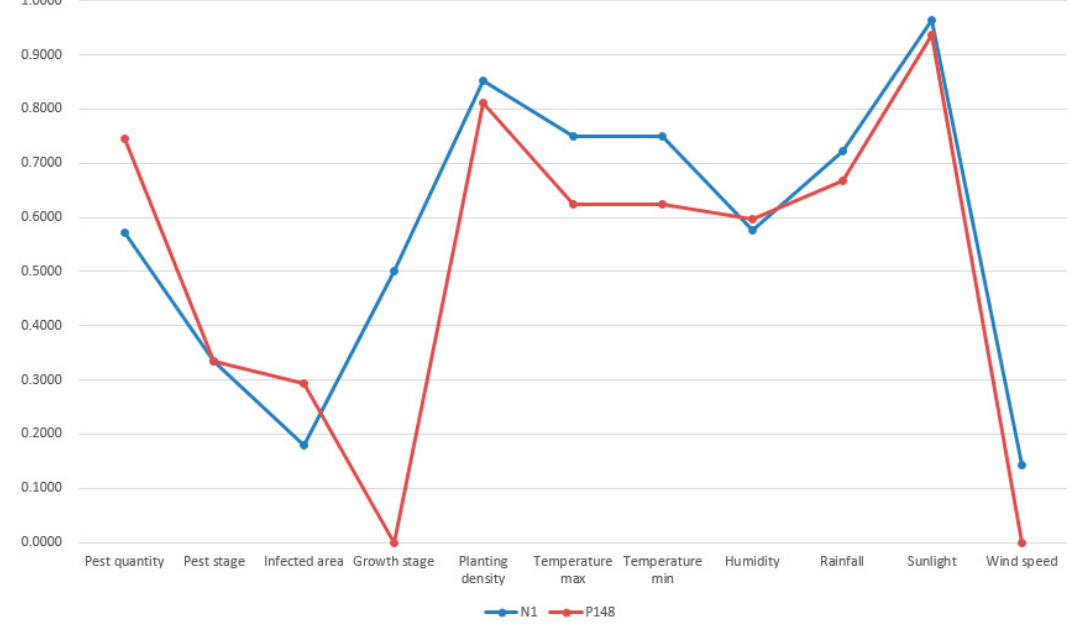
Figure 13. Visualization of the new case 1 and past case 148.